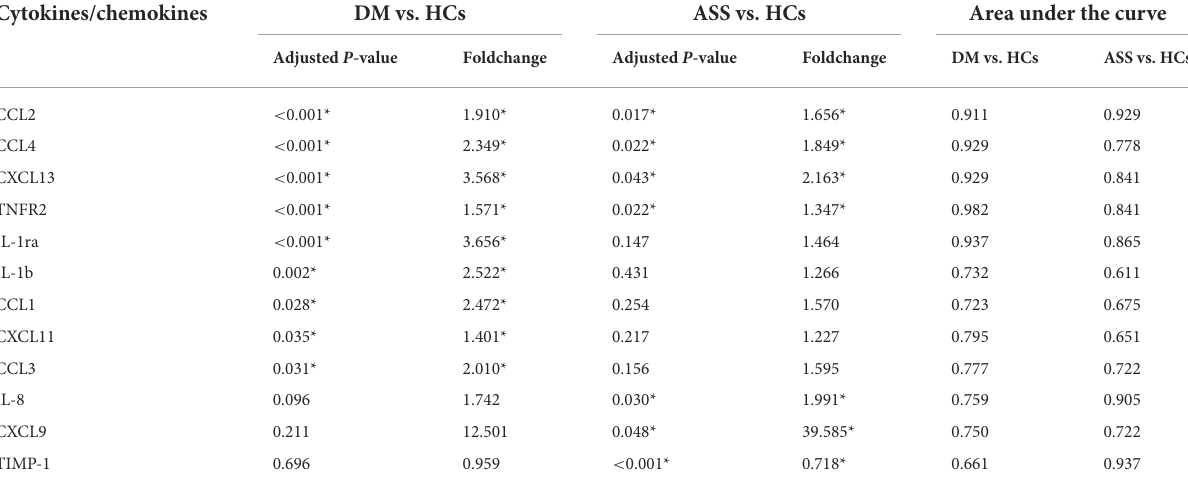
TABLE 3 Foldchange and diagnostic performance of serum cytokines/chemokines in DM and ASS. Cytokines/chemokines DM vs. HCs ASS vs. HCs Area under the curve Adjusted P -value Foldchange Adjusted P -value Foldchange DM vs. HCs ASS vs. HCs